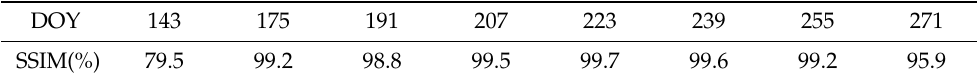
Figure 5. Leaf area index (LAI) visual results of SIM (the upper image of each pair is the input and the lower is the output) at the CSD area for all input days. The blanks and gaps in the upper im- ages in each pair result from the removal of clouds, cloud shadows, and scan line corrector failure. Table 3. Structural similarity measure (SSIM) between input and output LAI images for the CSD area.